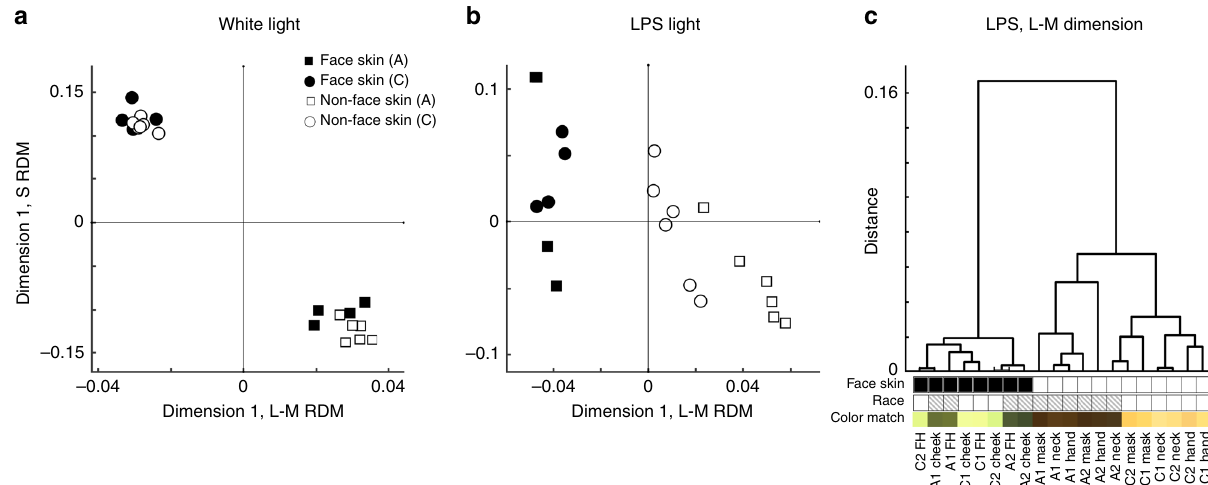
Fig. 7 Paradoxical color matches for faces is encoded by the more recently evolved (L – M) system. a Color matches for skin were evaluated for the extent to which they modulated the L – M versus S cone systems; these values were then subjected to a hierarchical clustering algorithm to determine the relative similarity among matches across the various skin samples; data from 20 participants. The plots show multidimensional scaling (MDS) relating the fi rst dimension of the representational dissimilarity matrix (RDM) for the S component against the fi rst dimension of the RDM for the L – M component, for matches under white light. Matches were made to face skin: cheek and forehead; and non-face skin: masked forehead, neck, hand. Face skin and non-face skin are not separable with either the L – M or the S dimensions. b As for panel a , but for matches made under low-pressure sodium light. Face skin and non- face skin are separable with the L – M dimension but not the S dimension; the L – M dimension also separates body skin by race. c Dendrogram showing the relative dissimilarity distances of the L – M component of the matches under LPS light. The main branch separates face skin from non-face skin; a secondary branch separates race among matches to body skin, but not face skin. Source data are provided as a Source Data fi le